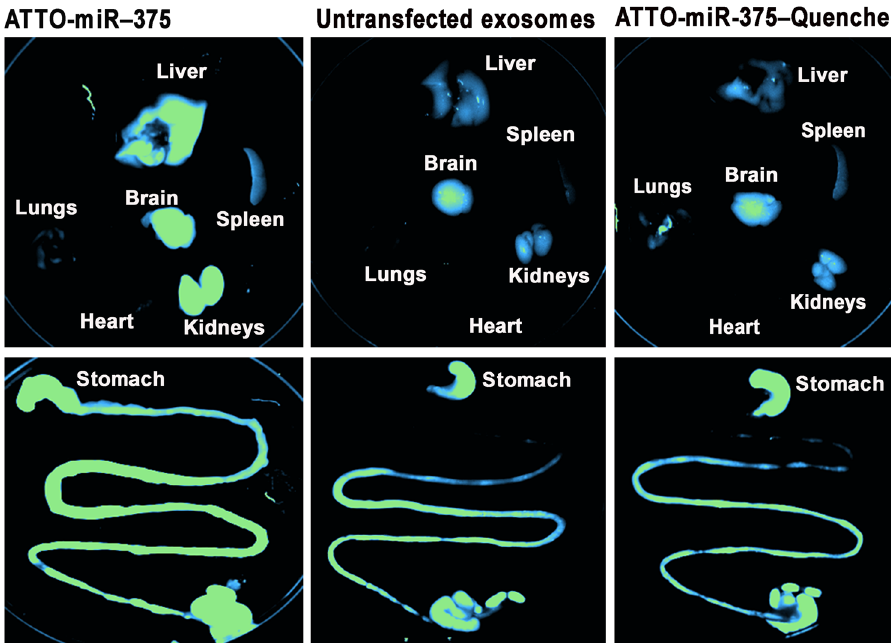
Figure 4. Assessment of microRNA degradation using a dual-label protocol in mice. Distribution of synthetic 5ATTO633N-miR-375 and the corresponding quencher (3IAbRQSp) transfected into milk exosomes (1 × 10 12 /g of body weight) 6 hours after delivery of exosomes by oral gavage in Balb/c mice. The transfection with 5ATTO633N only was used as a control of transfection efficiency and labeling stability. Panels in this figure were assembled from multiple independent images; individual images in the grouped figure are separated by white